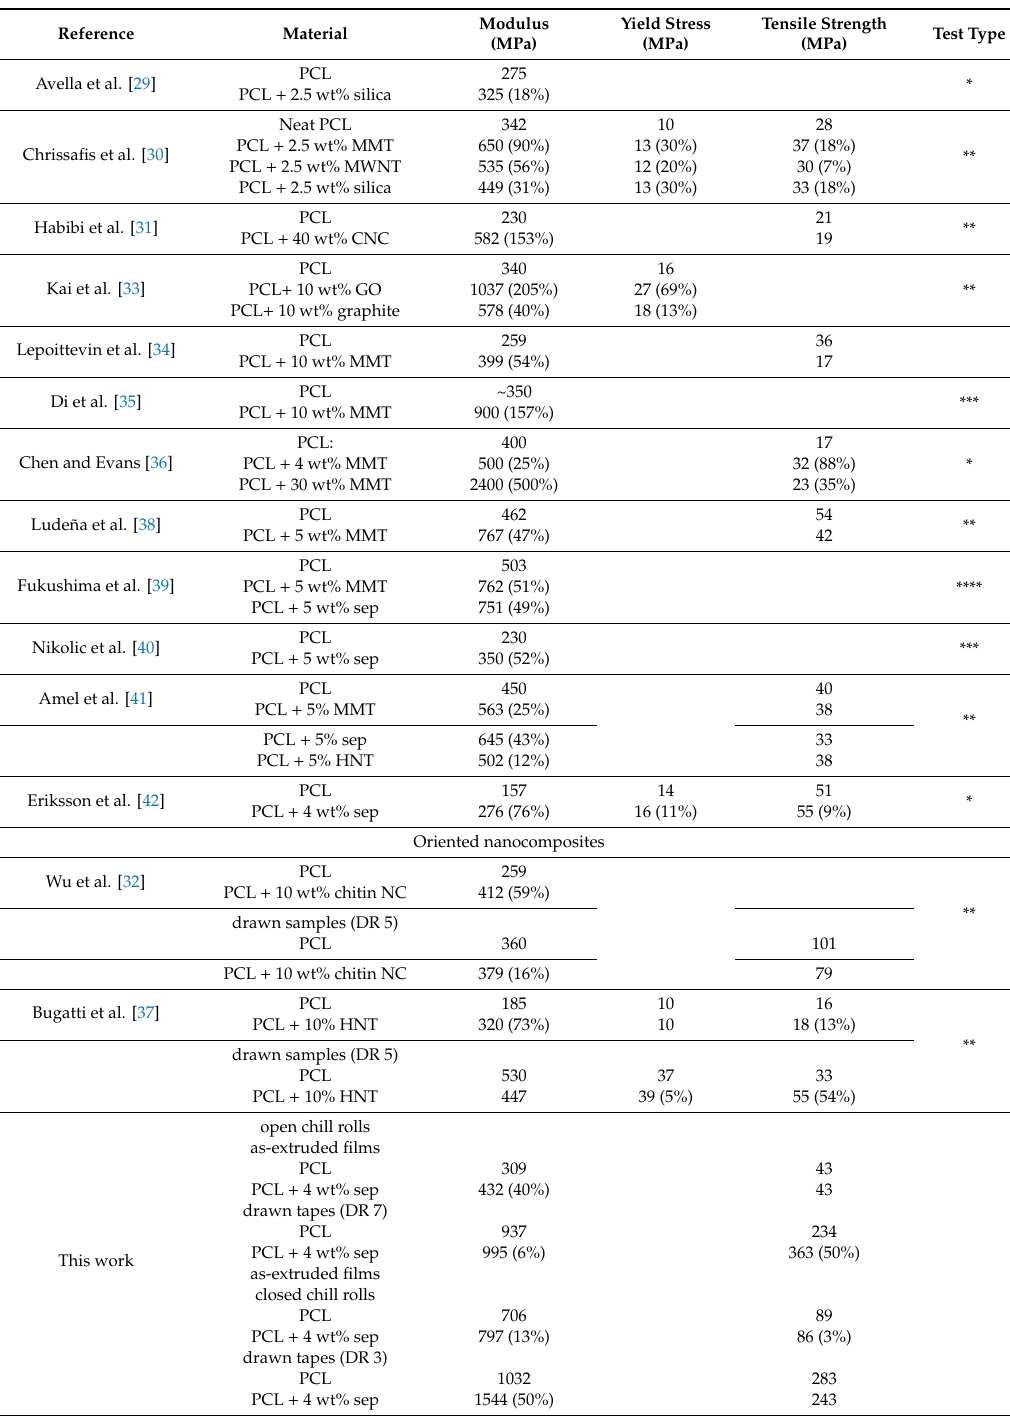
Table 4. An overview of the mechanical properties (Young’s modulus, yield stress, and tensile strength from tensile tests or dynamic mechanical analysis (DMA) tests at RT), extracted from literature [29–42]. Only the composition with the highest reported modulus and corresponding yield stress and tensile strength, or, in some case, the highest tensile strength, are presented together with values of neat PCL from each reference. The increase compared to neat PCL is listed in parenthesis. Any information on surface modifications is omitted. chitin NC = chitin nanocrystals, CNC = cellulose nanocrystals, CNT = carbon nanotubes, HNT = halloysite nanotubes, MMT = montmorillonite, MWNT = multi-wall carbon